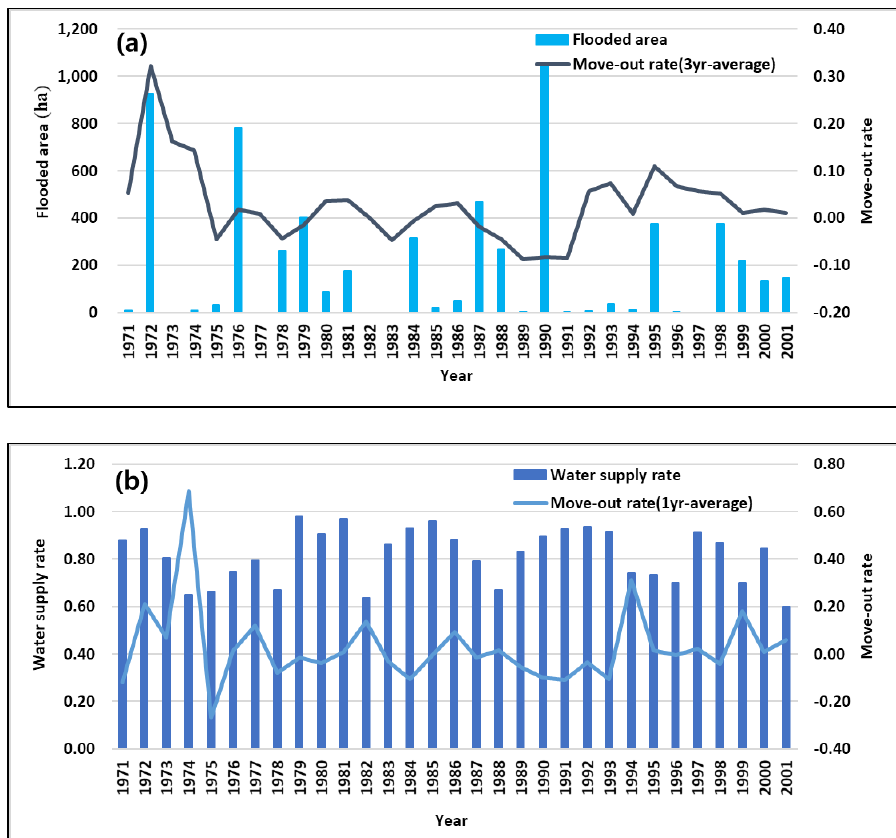
Figure 3. Relationship between natural disaster occurrence and the move-out rate ( a ) Flooded area, and ( b ) Water supply rate.